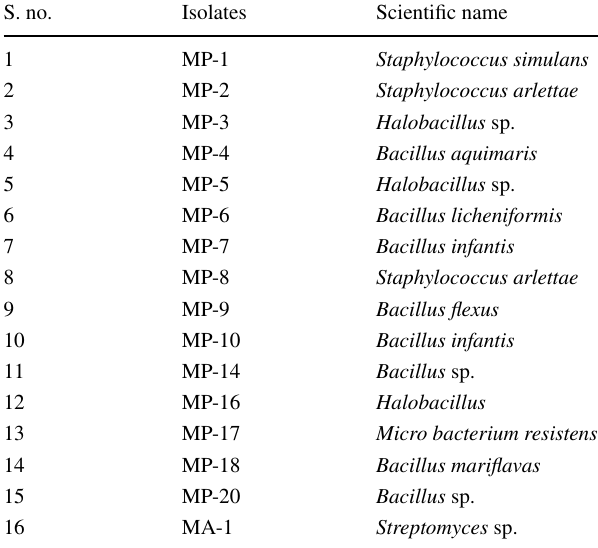
Table 2 Identification of cellulase producing bacteria in microbial consortium (Madhyam) culture